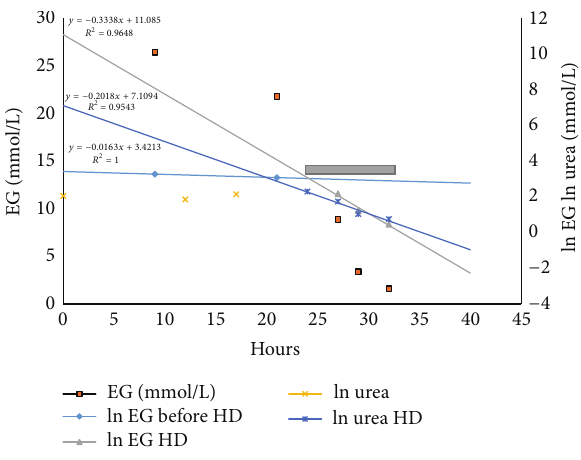
Figure 1: Gray bar represents